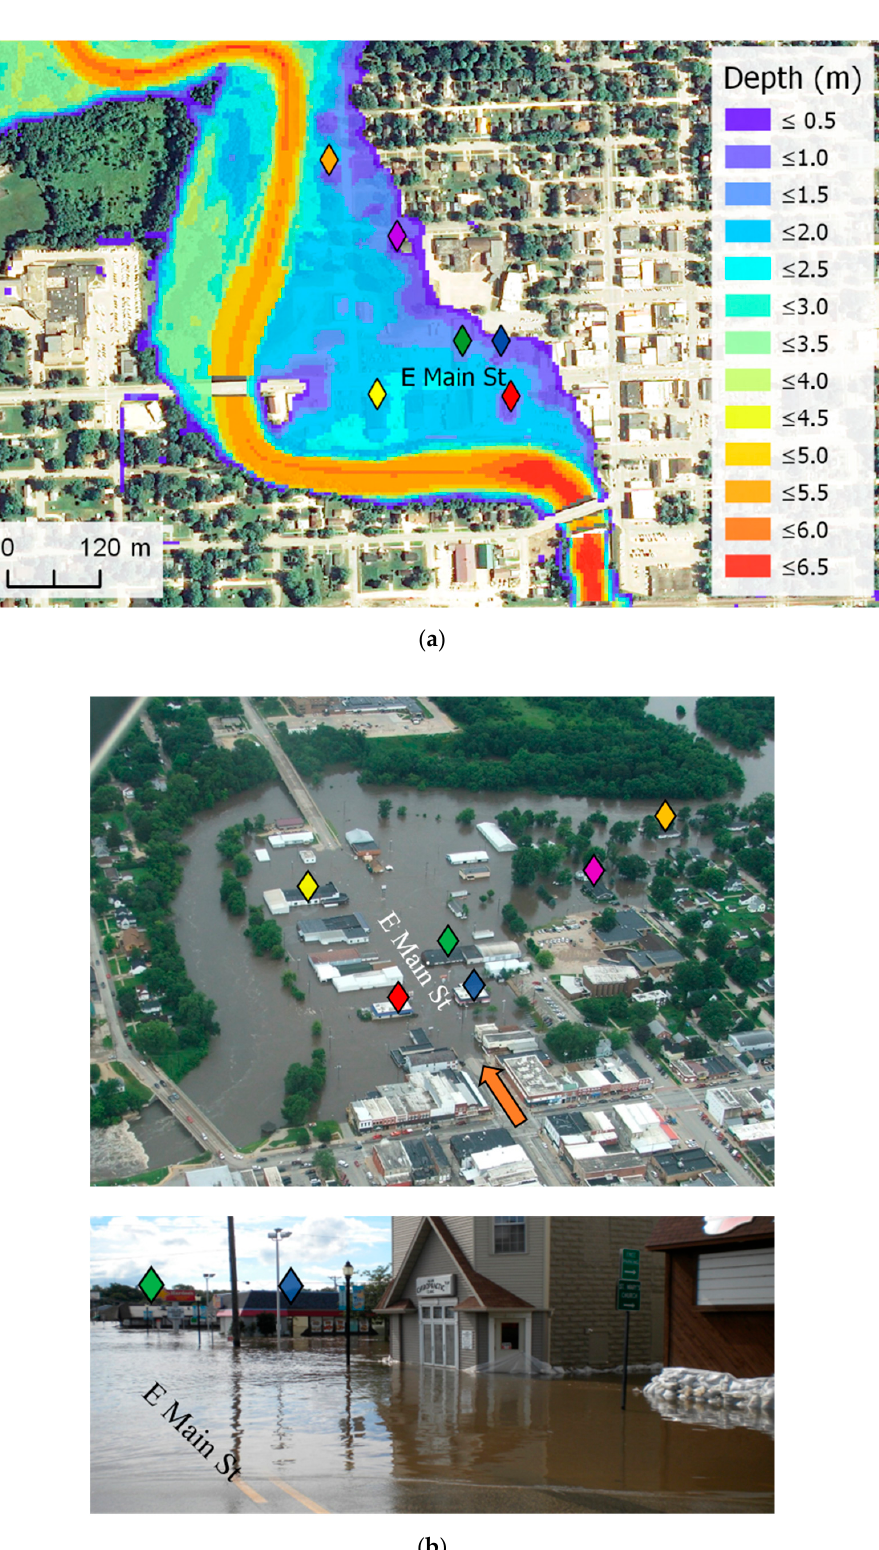
Figure 7 . The nested model was used to simulate the flood of July 2010 in downtown Manchester. ( a ) The maximum depth output from XPSWMM (XP—C2—IFC—h) was compared visually to ( b ) photos and aerial images of flooding provided by the City of Manchester. The points of interest are indicated by colored diamond markers on both the photos and flood map. The orange arrow is pointing in the westbound direction along E Main